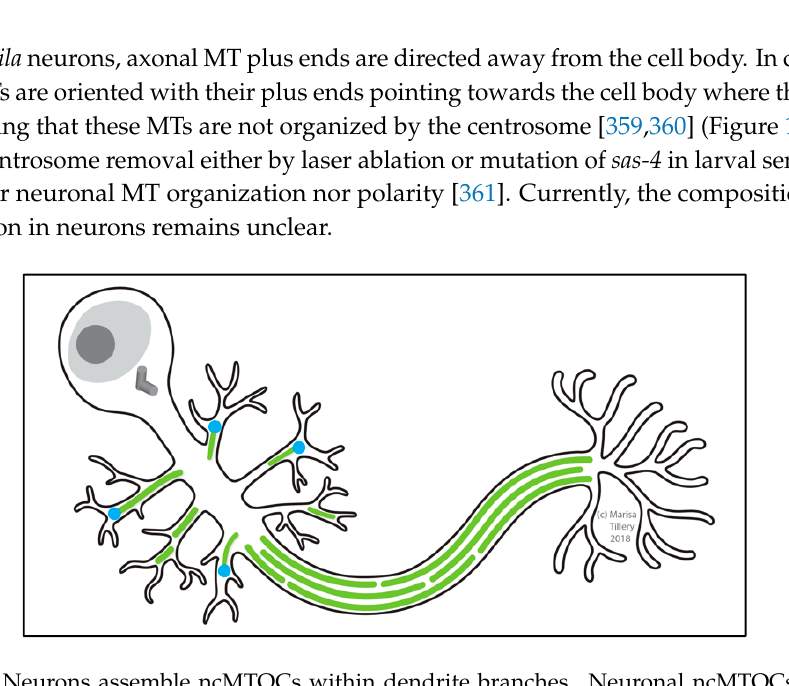
Figure 14. Neurons assemble ncMTOCs within dendrite branches. Neuronal ncMTOCs regulate dendrite branching. The nucleus is dark grey; MTs are green; ncMTOCs are blue.